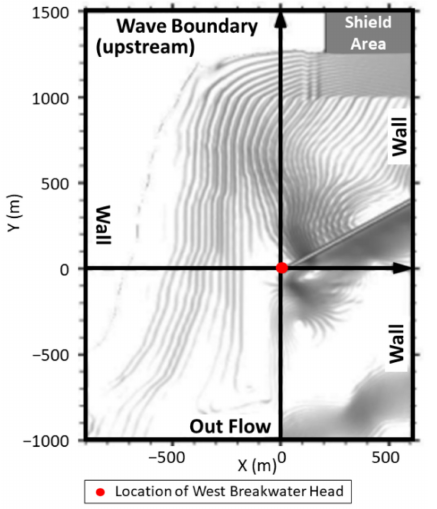
Figure 5. Model domain for numerical simulation.